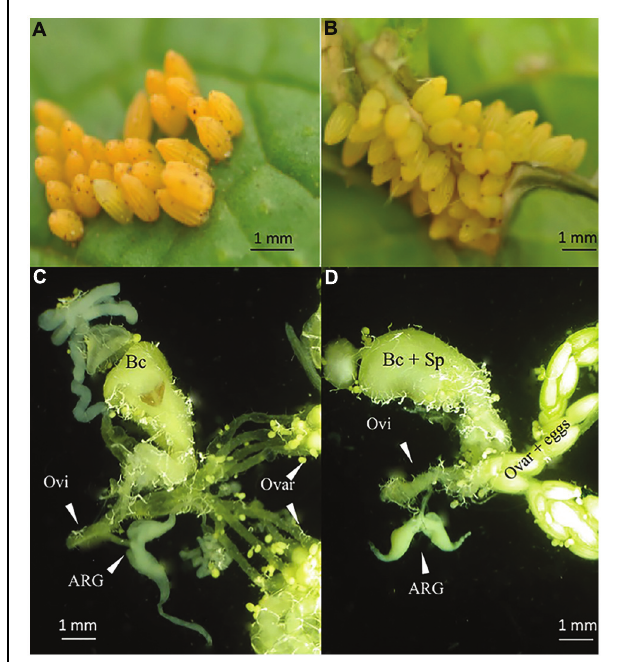
FIGURE 1 | Hypersensitive response (HR)-like necrosis of Brassica nigra plants induced by Pieris eggs and female reproductive tract. (A) Pieris brassicae egg clutch on a leaf showing no necrosis (HR − ; credits: E. Griese), (B) P. brassicae egg clutch inducing strong necrosis (HR + ; credits: E. Griese), (C) reproductive tract of a virgin P. brassicae female, and (D) reproductive tract of a mated P. brassicae female. Ovi, oviduct; ARG, accessory reproductive gland; Ovar, ovariole; Bc, bursa copulatrix; Sp,